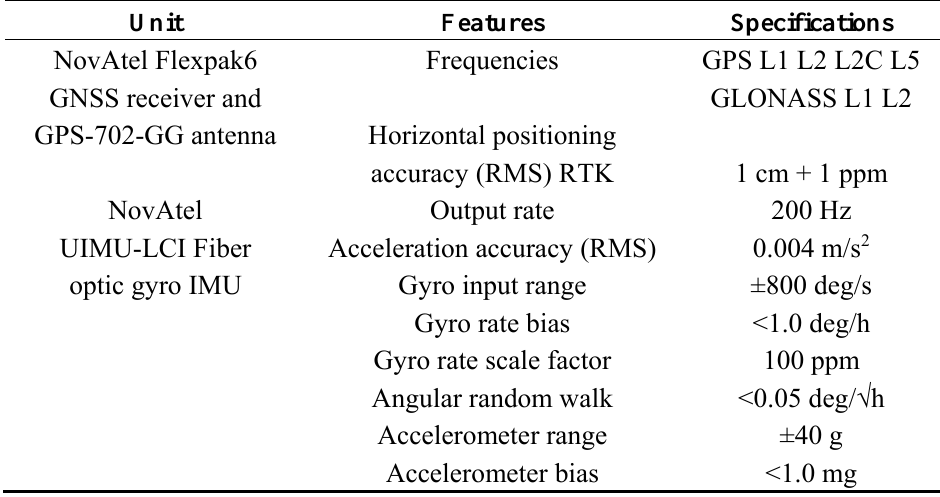
Table 2. The technical specifications of the navigation system (NovAtel SPAN GNSS-IMU a ).